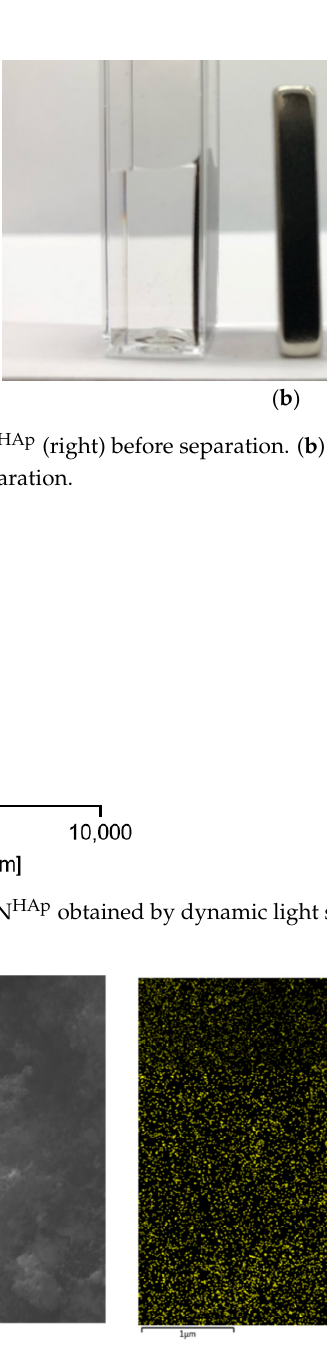
Figure A3. EDX-Mapping of the SPION HAp after drying dispersed nanoparticles on air. The Kα of carbon (yellow), oxygen (red), phosphor (green), calcium (blue), and iron (violate) and are shown.